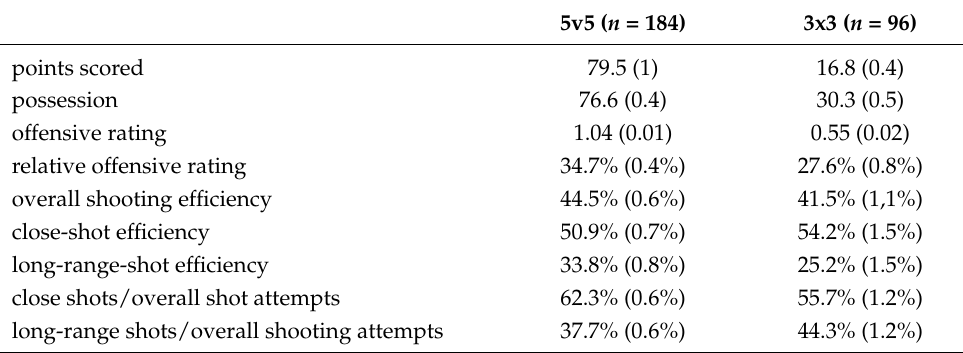
Table 2. Descriptive data of considered parameters (mean ±